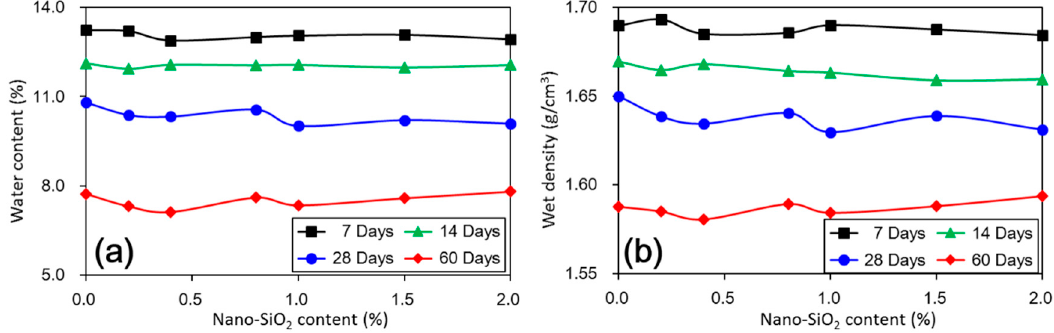
Figure 5. ( a ) Water content of treated loess with different nano-SiO 2 contents and curing days; ( b ) Wet density of treated loess with different nano-SiO 2 contents and curing days.